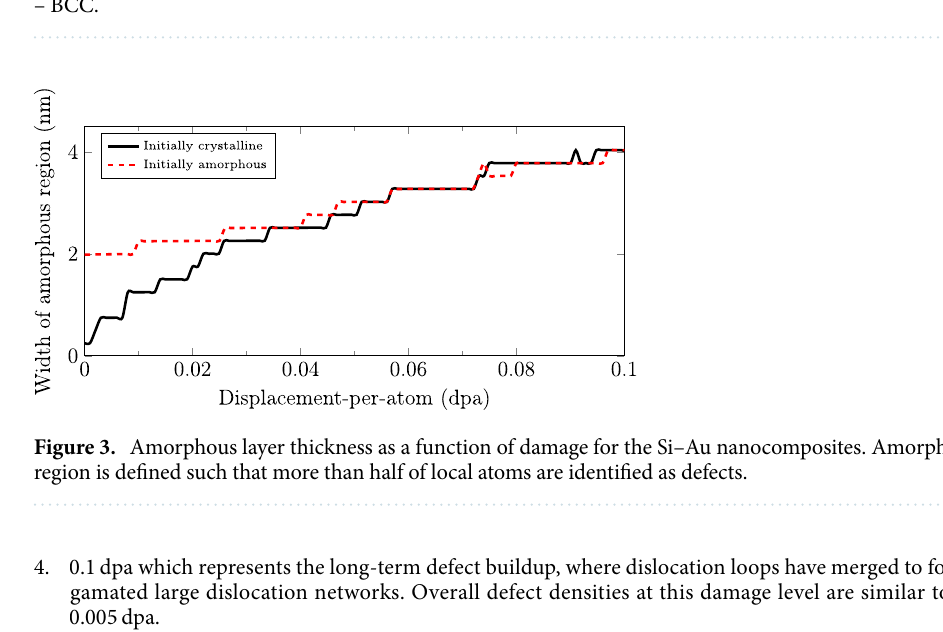
Figure 2. Amorphous Si region growth during irradiation. ( a , c , e ) 0 dpa , 0.015 dpa , 0.1dpa damage level for the initially-crystalline Si–Au nanocomposite. ( b , d , f ) 0 dpa , 0.015 dpa , 0.1dpa damage level for the initially- amorphous Si–Au nanocomposite. Snapshots are rendered at 40Å about the initial interfacial position. Atoms are colored by structure type: White – Amorphous/Defect, Pink – Diamond Si, Green – FCC, Red – HCP, Blue – BCC.